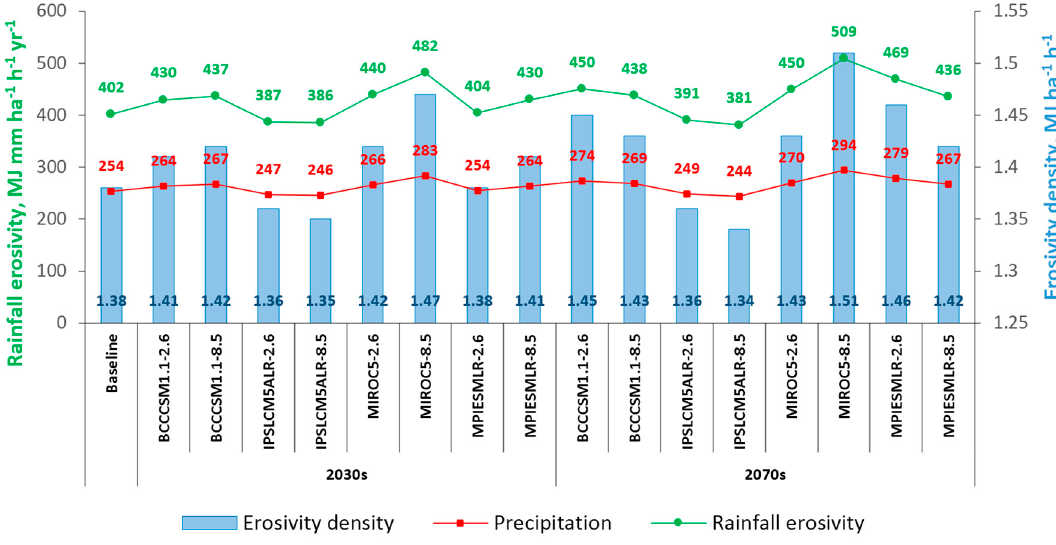
Figure 8. Annual precipitation, R factor and erosivity density for different scenarios and periods.